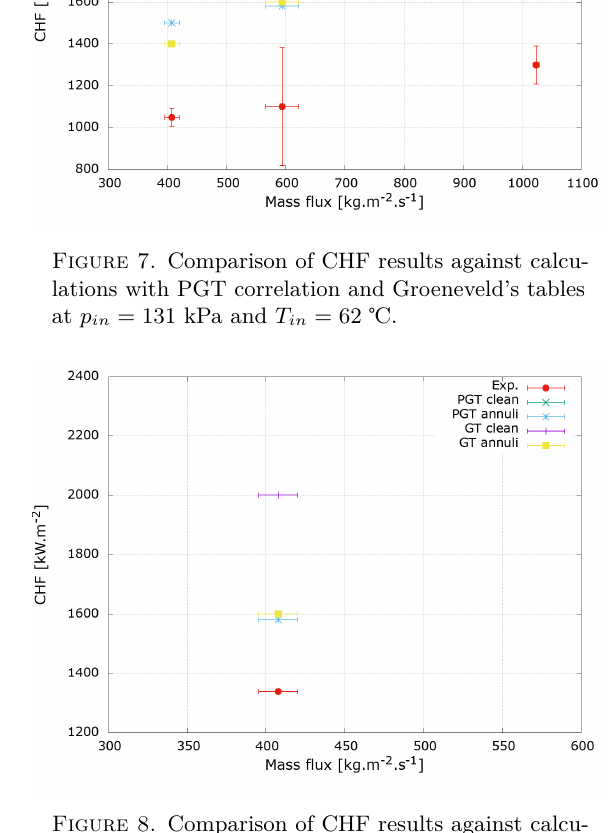
Figure 10. Comparison of CHF results against calcu- lations with PGT correlation and Groeneveld’s tables at p in = 323 kPa and T in = 94